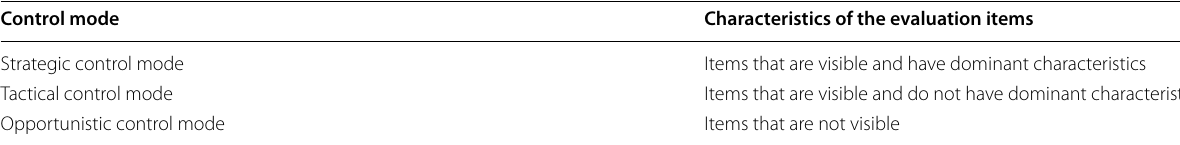
Table 2 The correspondence between control mode and characteristic of the evaluation items Control mode